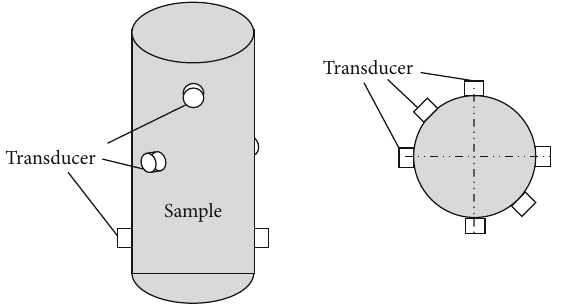
Figure 5: Illustration of the transducer